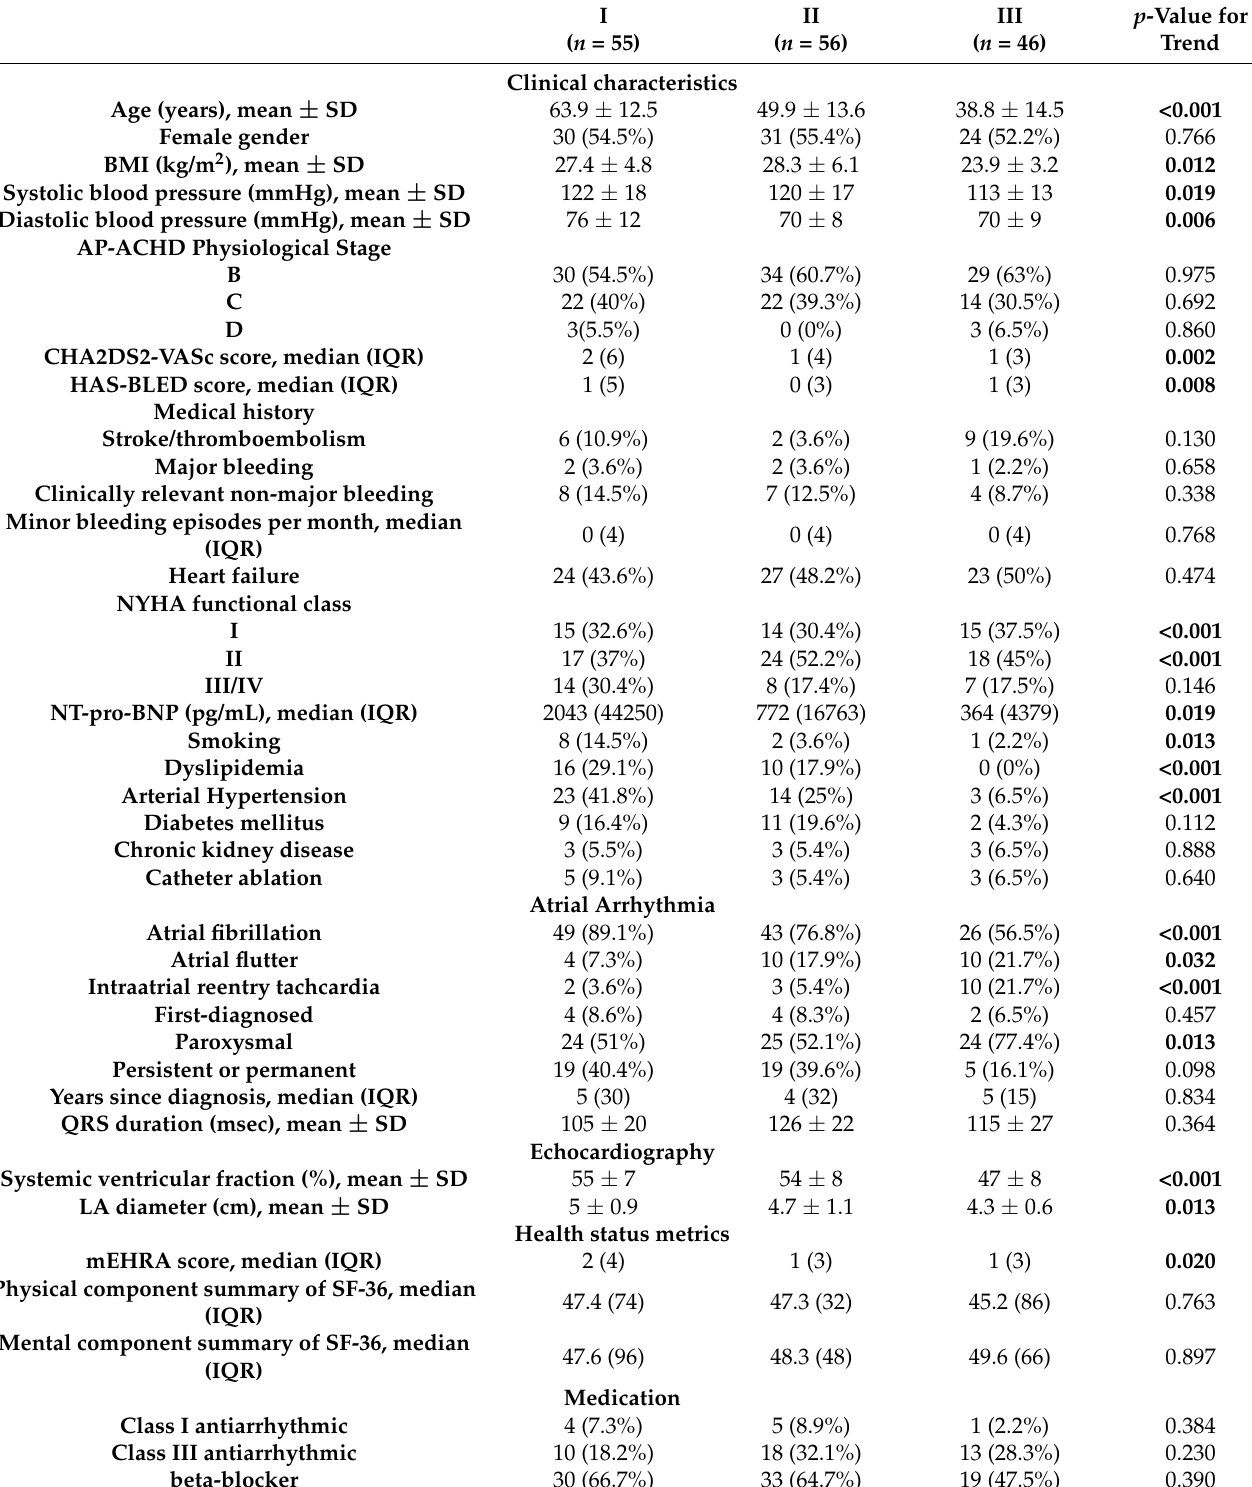
Table 1. Descriptive and Clinical Characteristics by Anatomic